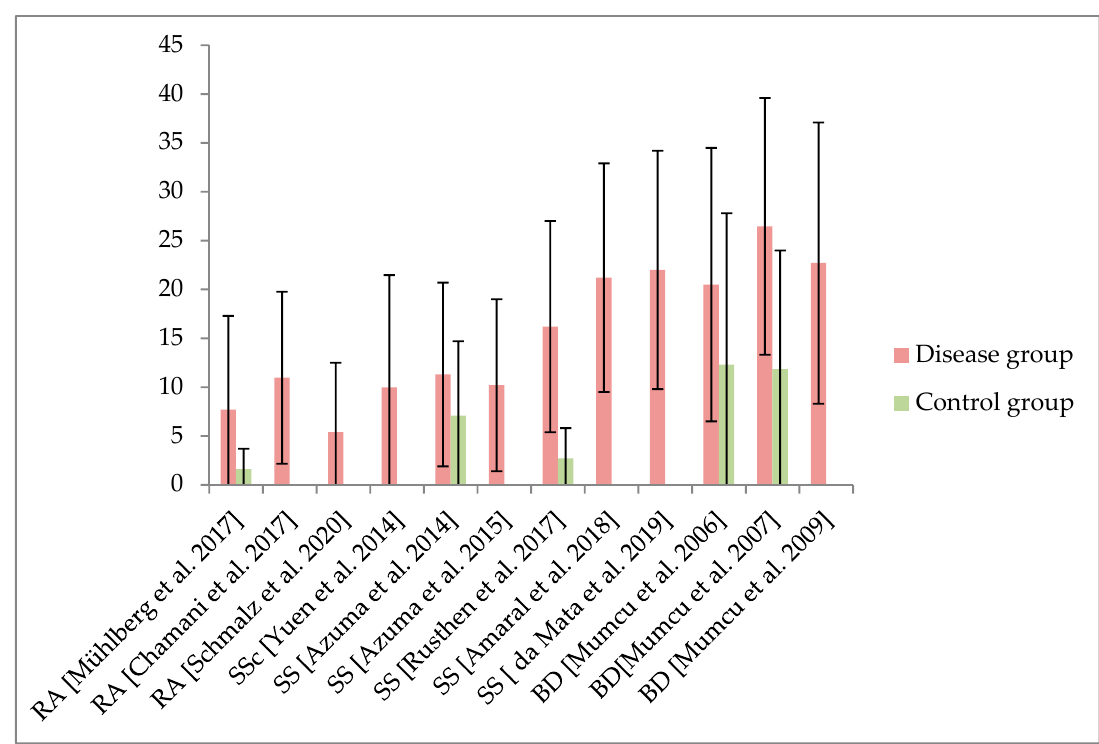
Figure 2. Findings of OHIP (oral health impact profile) 14 in patients suffering from rheumatic diseases, including rheumatoid arthritis (RA), systemic sclerosis (SSc), Sjögren syndrome (SS), and Behcet’s disease (BD). For comparability, only studies presenting mean value ± standard deviation are displayed in this figure. If applicable, results of the control group are presented as well.